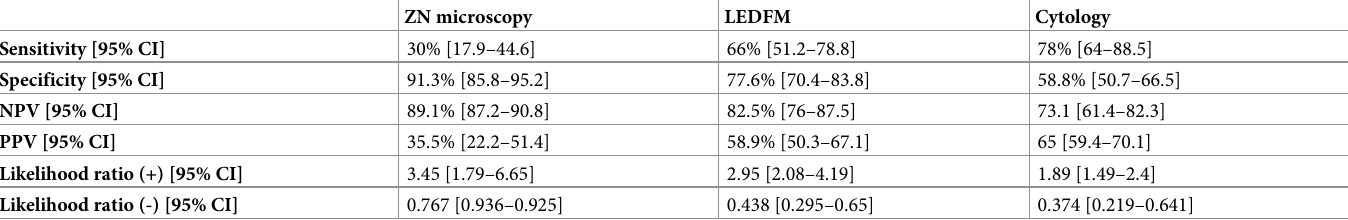
Table 4. Overall diagnostic accuracy of conventional ZN microscopy, LEDFM, and cytology against culture result data drowns from ALERT and St. Peter TB spe- cialized hospital. Addis Ababa,